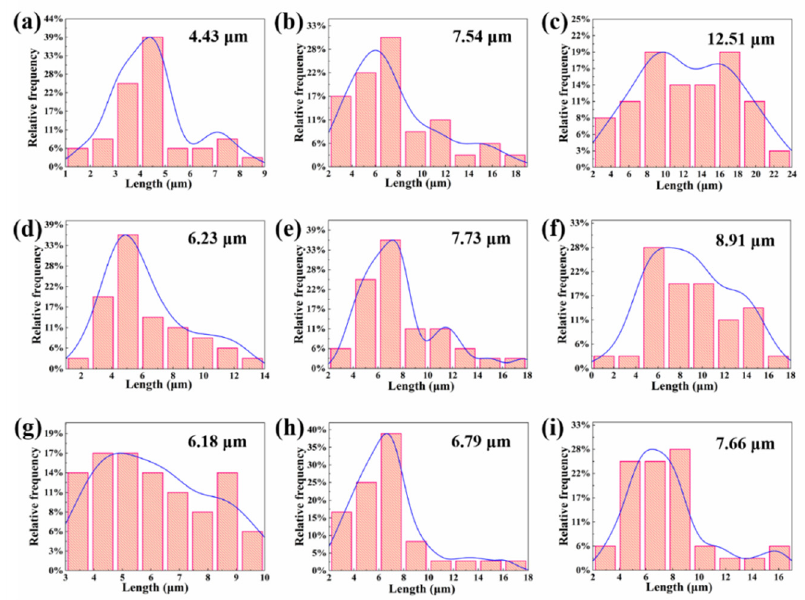
Figure 2. Length distributions of ( a – c ) Bi 4 Ti 3 O 12 precursor, ( d – f ) BaBi 4 Ti 4 O 15 precursor, and ( g – i ) BaTiO 3 mesoscale particles synthesized at different temperatures.